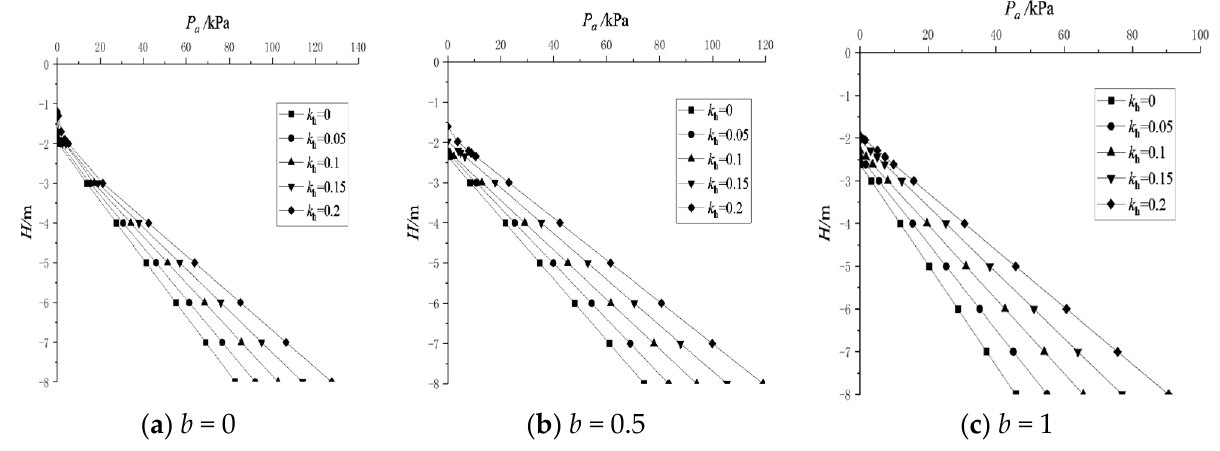
Figure 4. Intensity distribution of Rankine active earth pressure ( k v = 0). (2) Figures 4 and 5 indicate that with the decrease of the seismic coefficients or increase of the unified strength factor, the acting scope of Rankine active earth pressure moves downward slightly, and the intensity reduces. For instance, the earth pressure at 4 m depth with k h = 0.1, k v = 0.1 decreases by 44% when b increased from 0 to